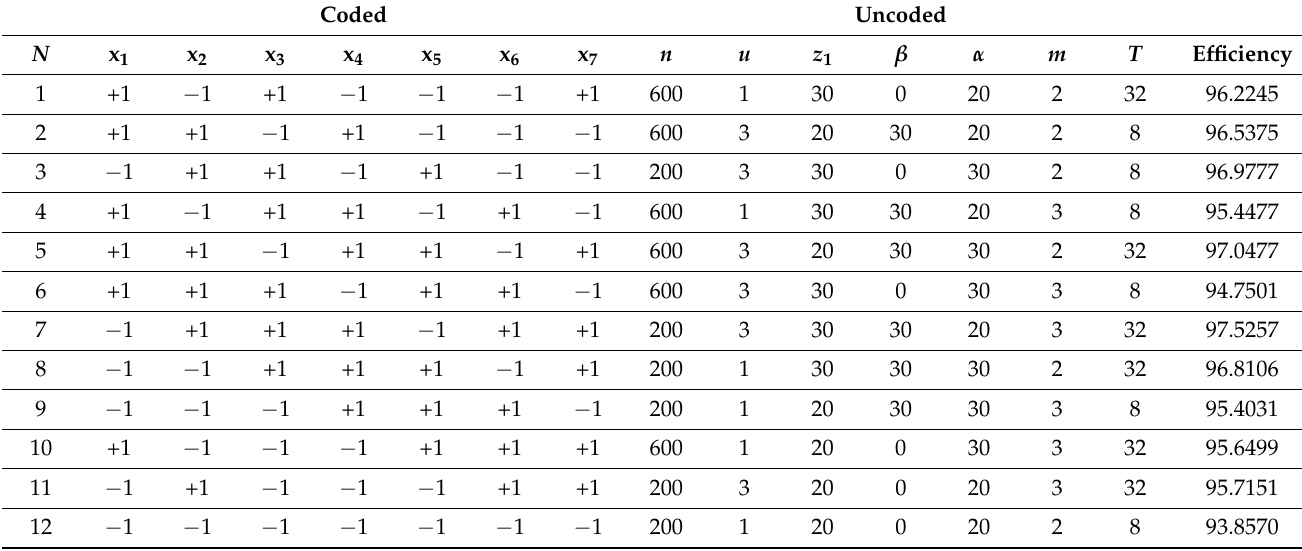
Table 2. Design matrix of Plackett–Burman